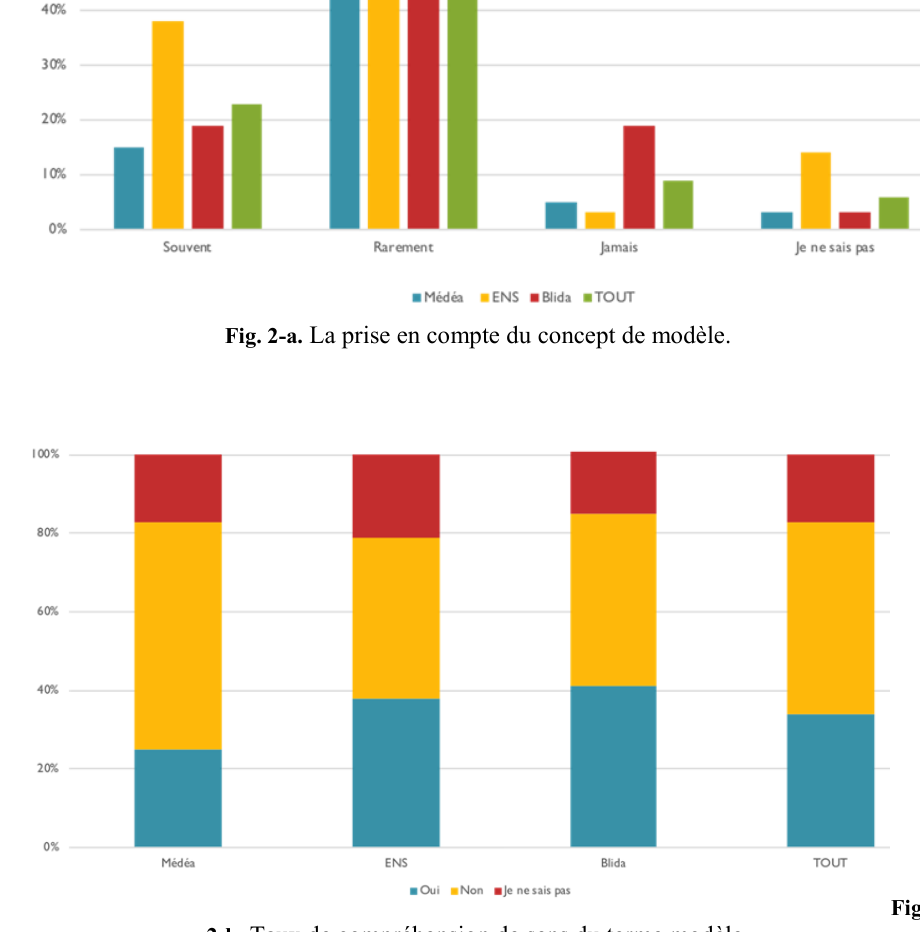
2-b. Taux de compréhension de sens du terme